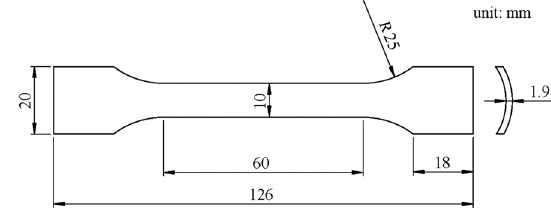
Figure 6 Tensile specimen size